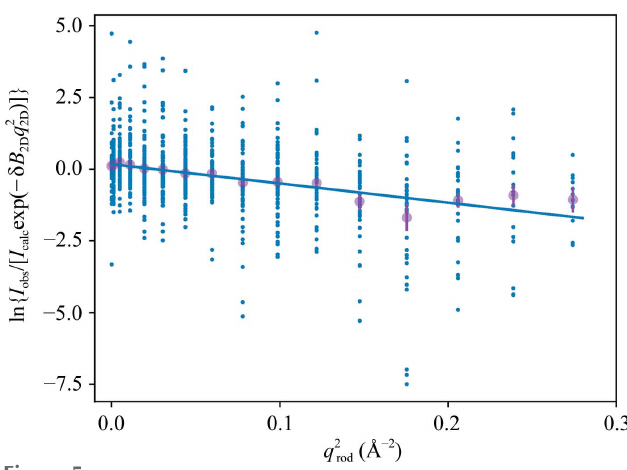
Figure 5 Anisotropic intensity decay. Blue dots, ln{ I obs /[ I calc exp( (cid:4) (cid:6) B 2D q 2D2 )]}, with (cid:6) B 2D = (cid:4) 0.27 A˚ 2 , as a function of q 2 rod . Magenta dots, bin averages with error bars. Blue line, curve ln A (cid:4) (cid:6) B rod q 2 rod with (cid:6) B rod = 6.70 A˚ 2